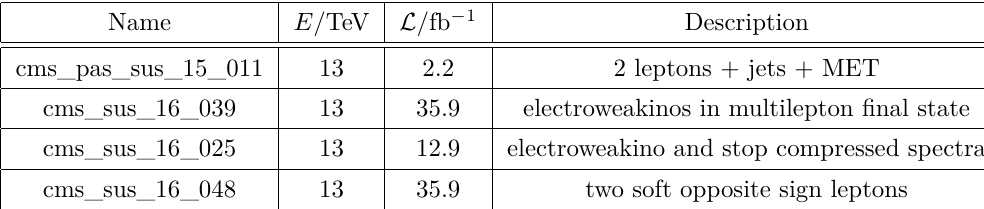
Table 7 . List of 13 TeV CMS analyses available in CheckMATE and which have been validated against published experimental results.